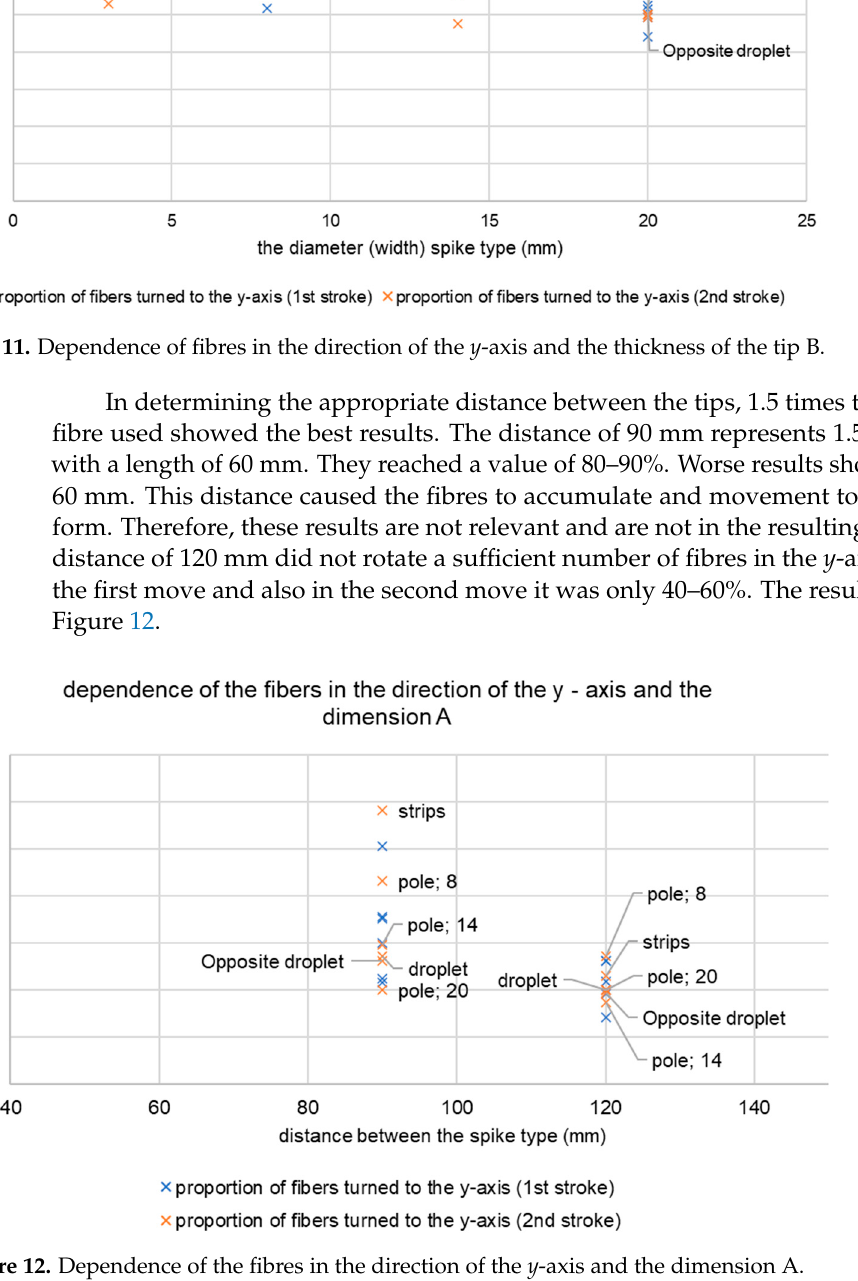
Figure 12. Dependence of the fibres in the direction of the y -axis and the dimension A.